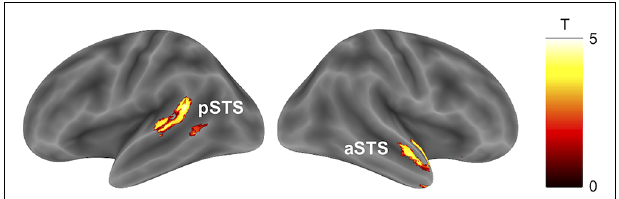
FIGURE 4 | Brain activity associated with the braking response to a pedestrian crossing. Activity in the left pSTS and right aSTS preceding a pedestrian crossing was positively correlated with the RT for that event (cluster-defining threshold: p < 0.001 uncorrected; cluster-extent threshold: